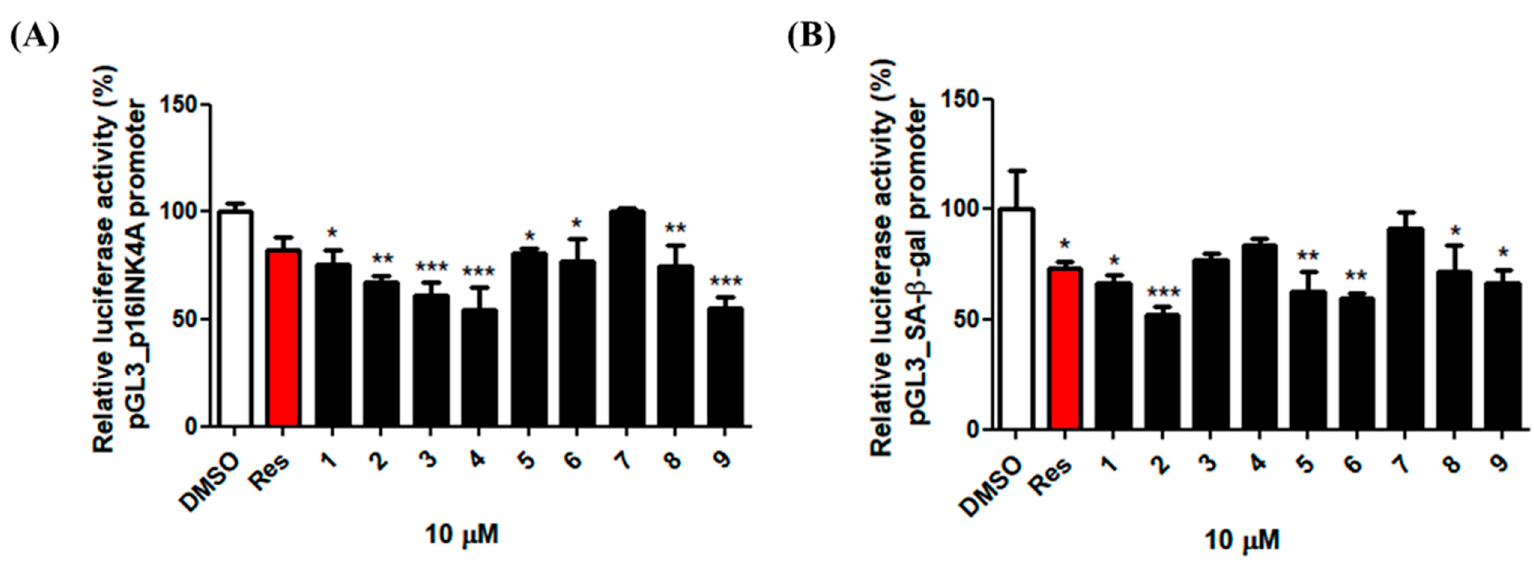
Figure 4. E ff ects of compounds 1 – 9 (10 µ M) on the p16INK4A and GLB1 transcription in the human dermal fibroblasts. Human dermal fibroblasts were transiently co-transfected with the pGL3-p16INK4A ( A ) or pGL3-GLB1 ( B ) promoter with β -galactosidase as a transfection control. Cells were treated overnight with the compounds 1 – 9 (10 µ M). The luciferase activity was determined as the ratio of the firefly / Renilla luciferase activities. The activities of the p16Ink4A promoter and the GLB1 promoter in the presence of the compounds 1 – 9 relative to that in the absence of the compounds 1 – 9 are shown. * p < 0.05, ** p < 0.01, and *** p < 0.001, compared with control.